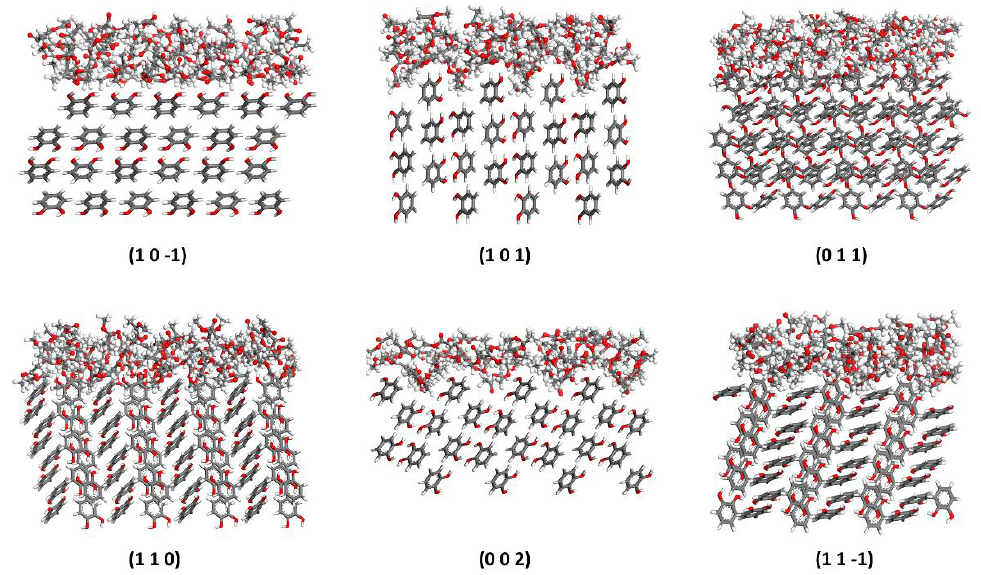
Figure 6. Methyl acetate molecular alignment on the six main possible crystal faces of catechol via a molecular dynamics (MD) simulation.